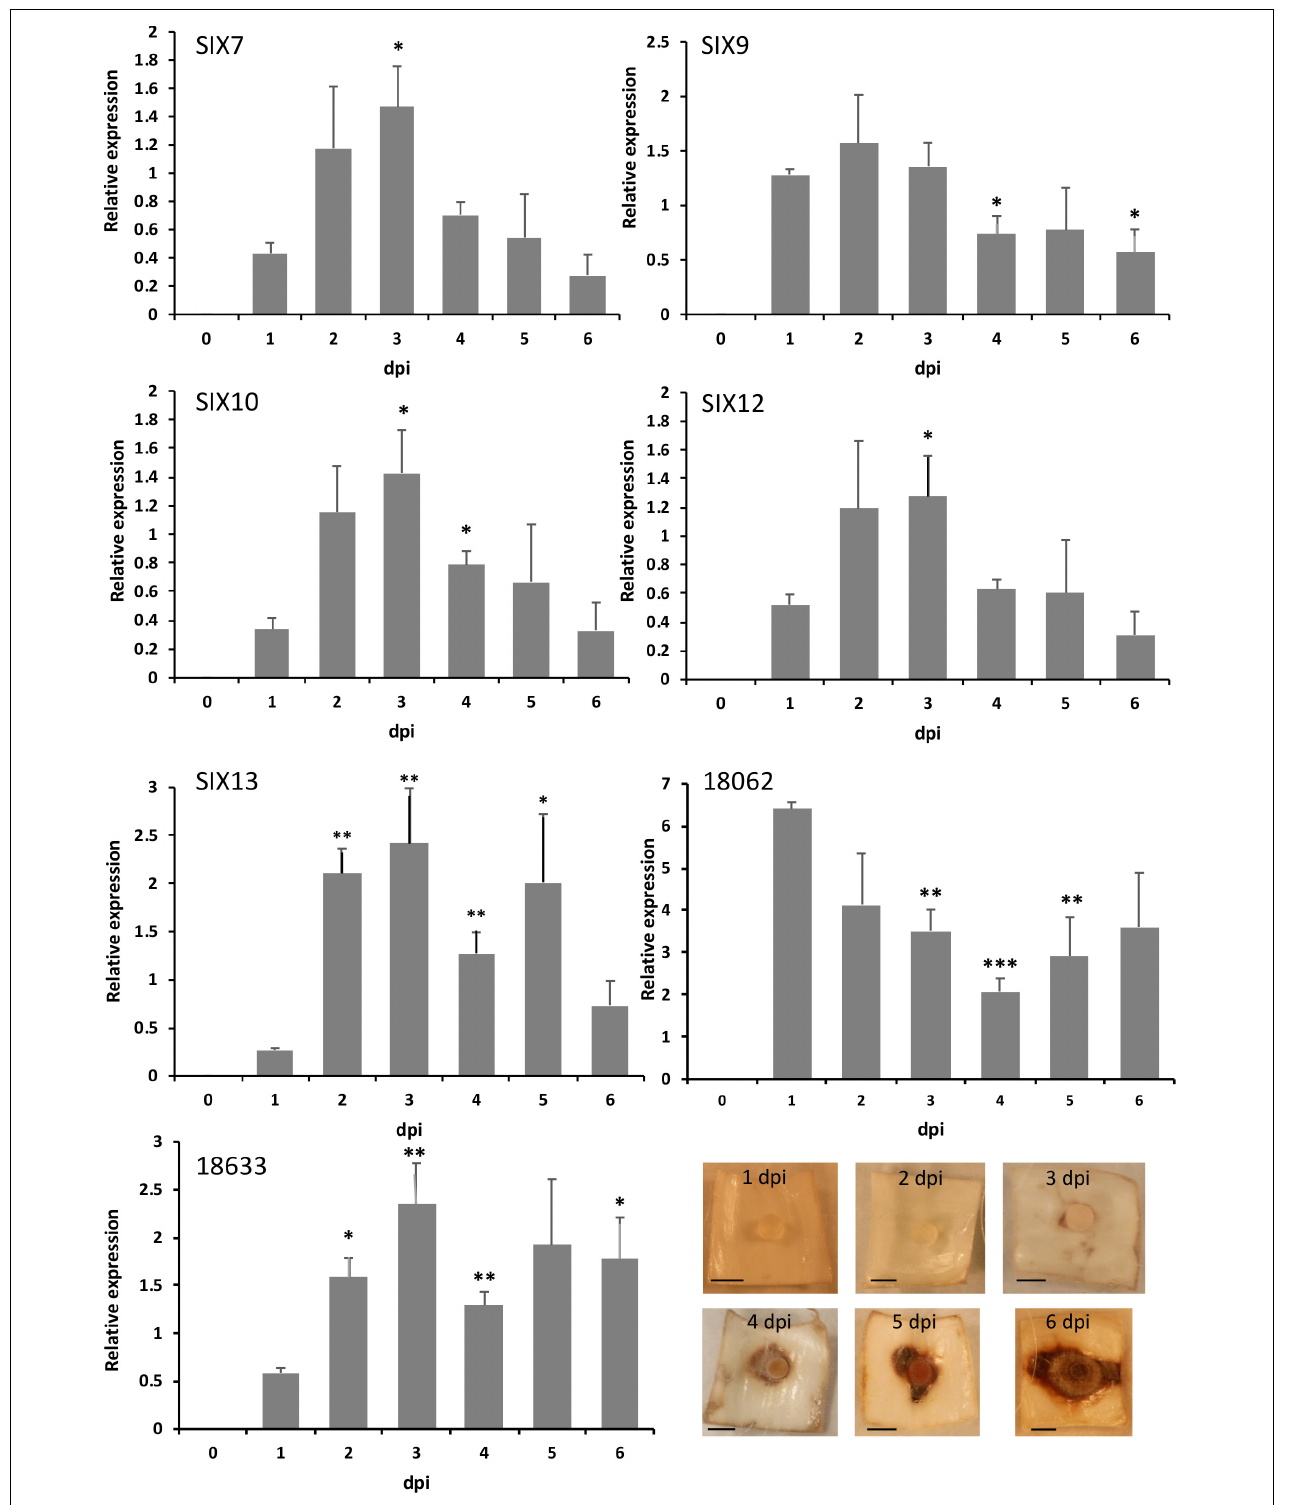
FIGURE 3 | Quantitative expression of SIX genes and two other putative effectors in planta following inoculation of Narcissus (cv. Carlton) scales with isolate FON63. Expression was calculated relative to the geometric mean of translation elongation factor 1- α and β -tubulin . Error bars show the standard error of the mean of four biological replicates; dpi, days post-inoculation. Asterisks indicate expression levels significantly different from 1 dpi based on two-tailed T -tests ( ∗ P < 0.05, ∗∗ P < 0.01, ∗∗∗ P < 0.001). Images show the progression of disease symptoms at the time-points used for RNA extractions; scale bars are 0.5 cm.